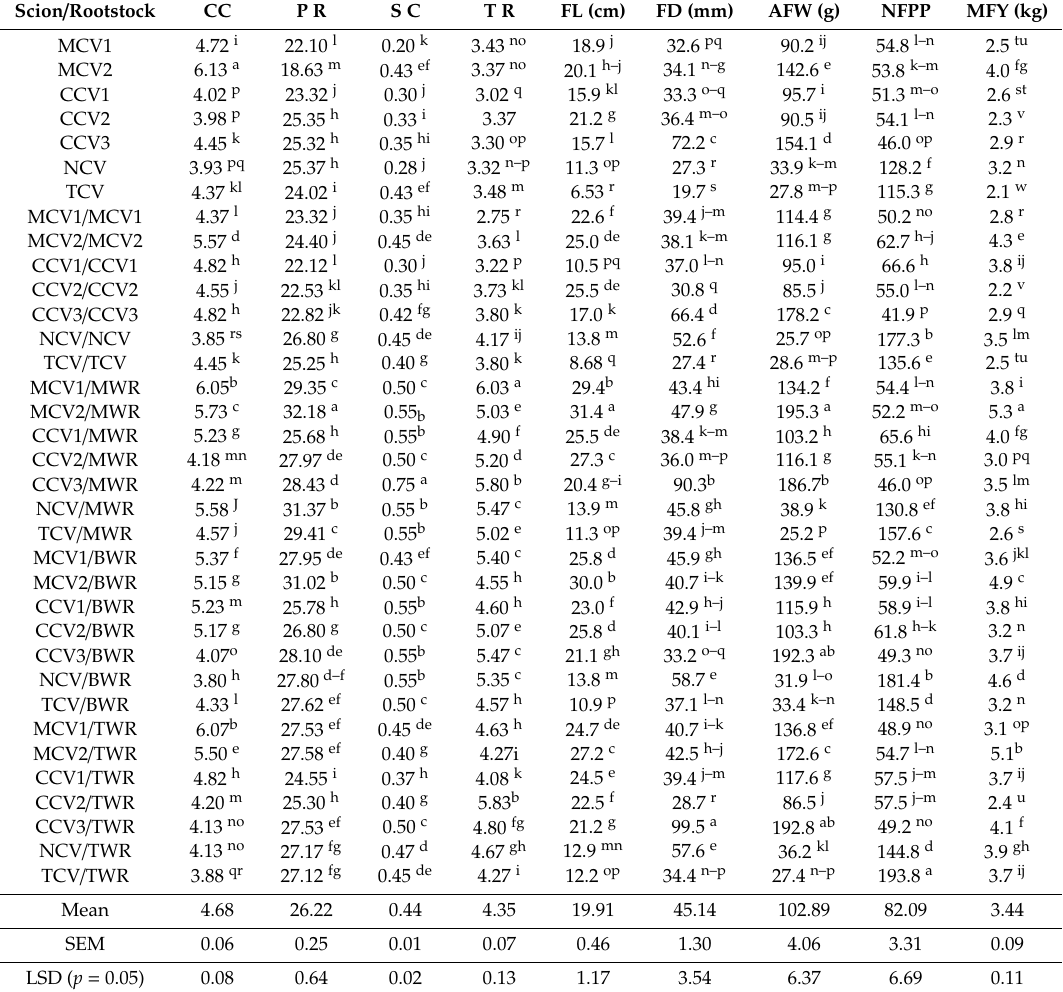
Table 4. Means of physiological, yield and yield component traits of the grafted, self-grafted and non-grafted eggplants genotypes studied across the cropping